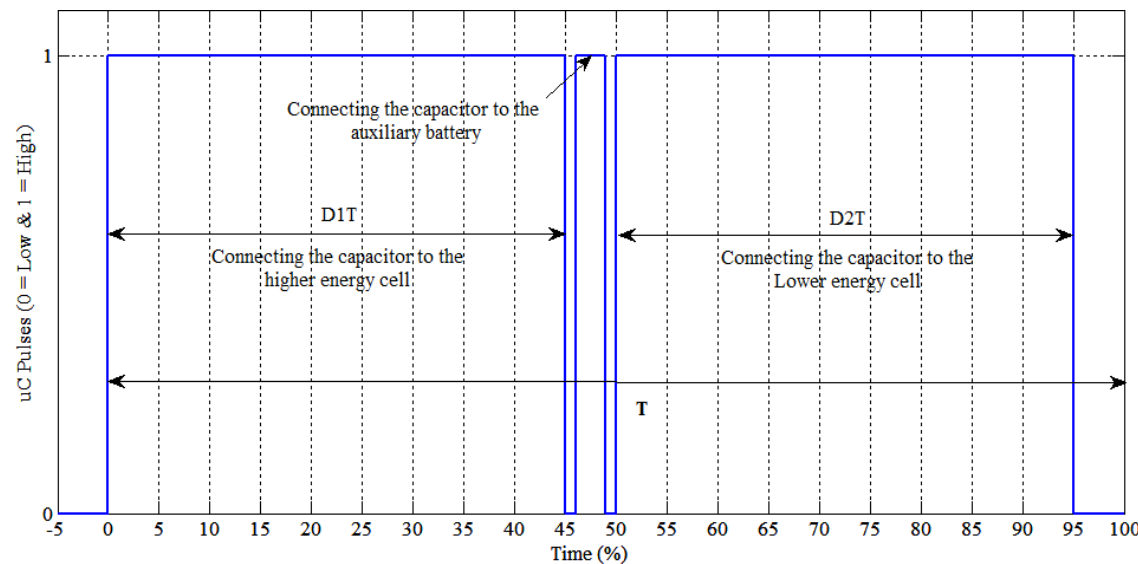
Figure 6. Modified single switched capacitor (SSC) balancing with the boosting technique pulses for one charge/discharge pulse.